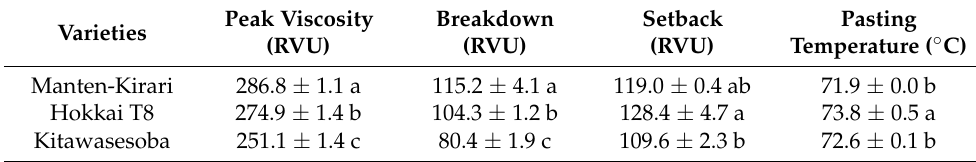
Table 2. RVA pasting properties of buckwheat